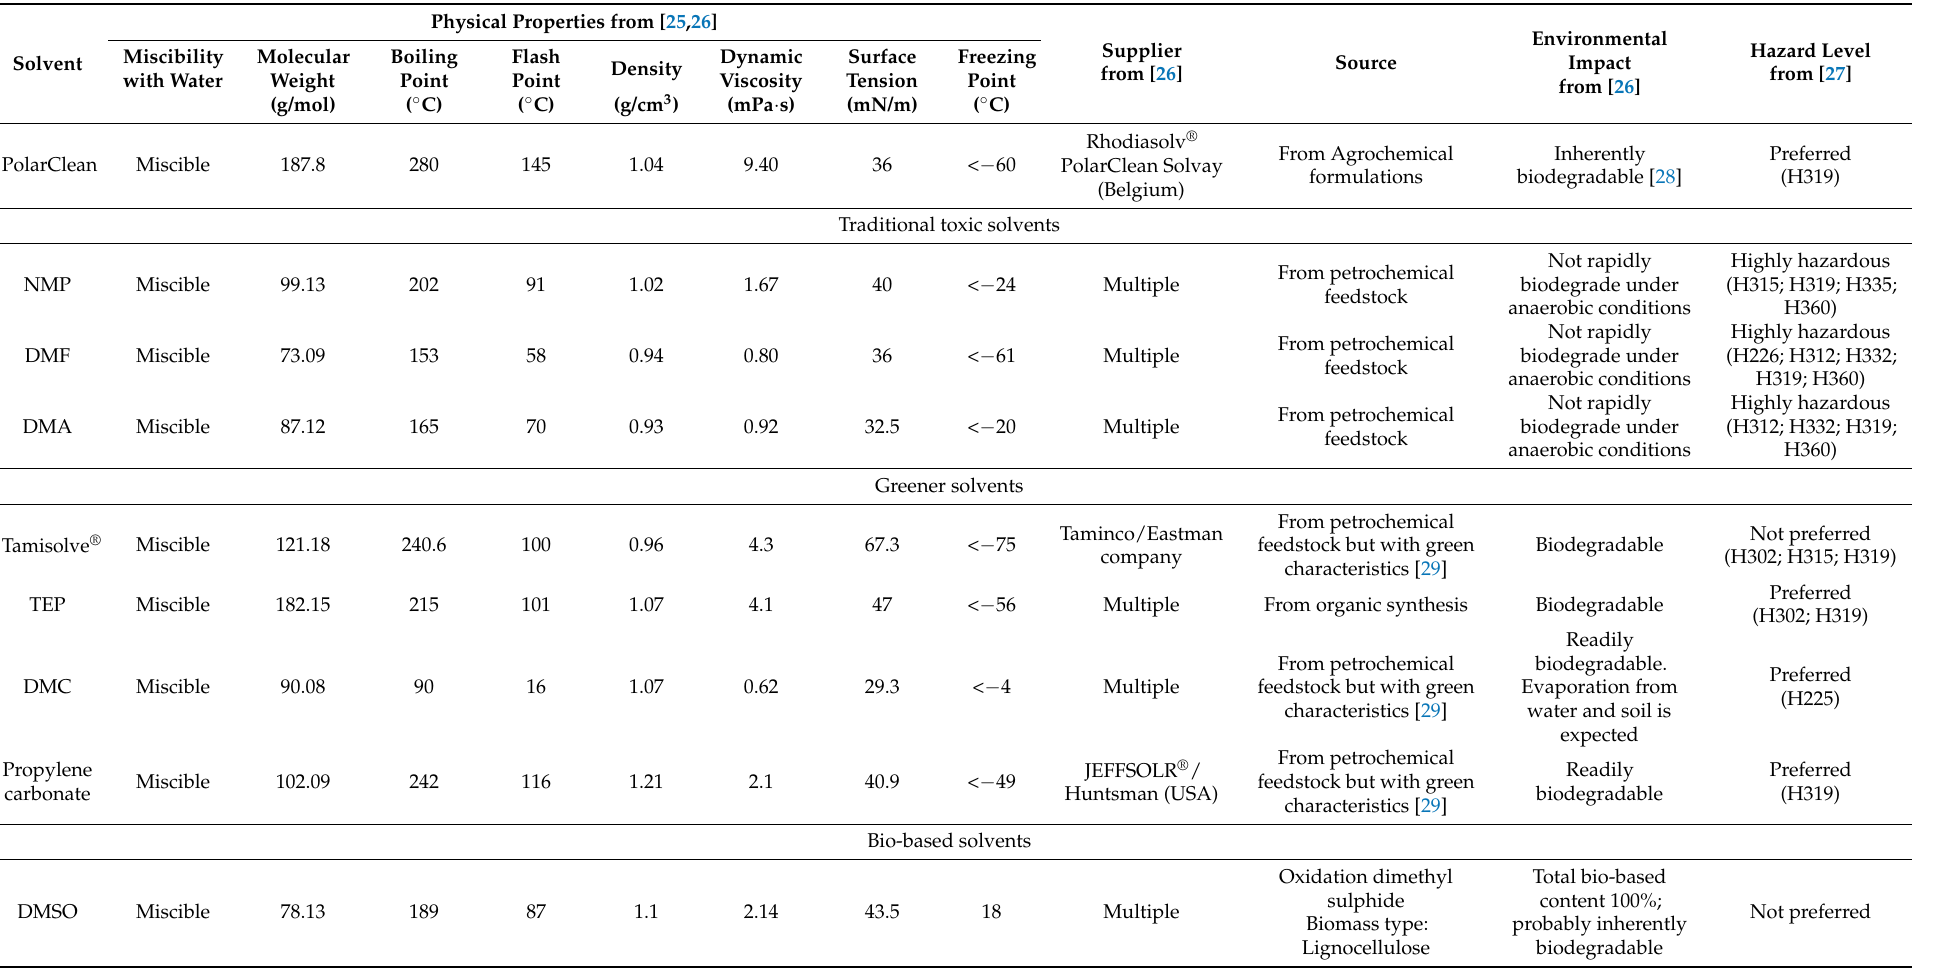
Table 1. Physical properties, environmental impact and hazard level for conventional toxic, greener and bio-based aprotic solvents employed in membrane preparation.